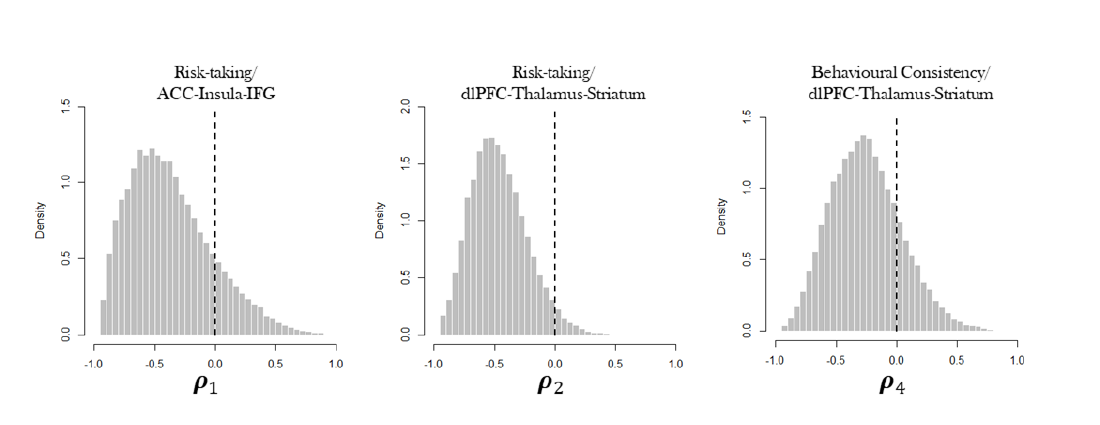
Figure 5. Marginal posterior distributions of the correlation parameters of interest in the covariance